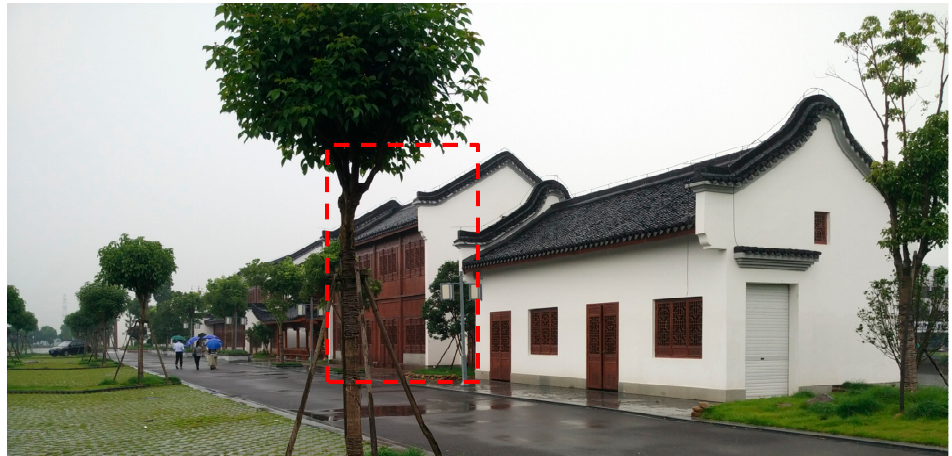
Figure 3. The tourist center and the office building marked with the red frame, which the solar cooling system serves. Table 1. The construction characteristics of the